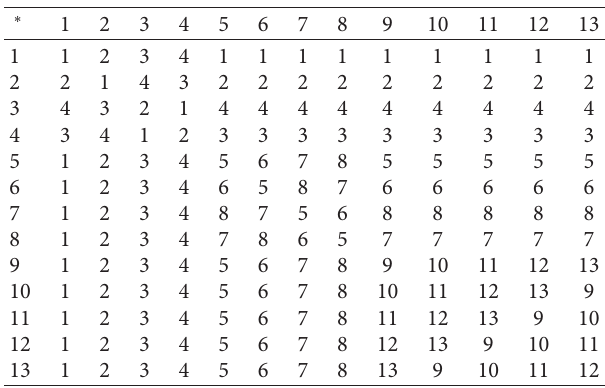
Table 6: Table of Example